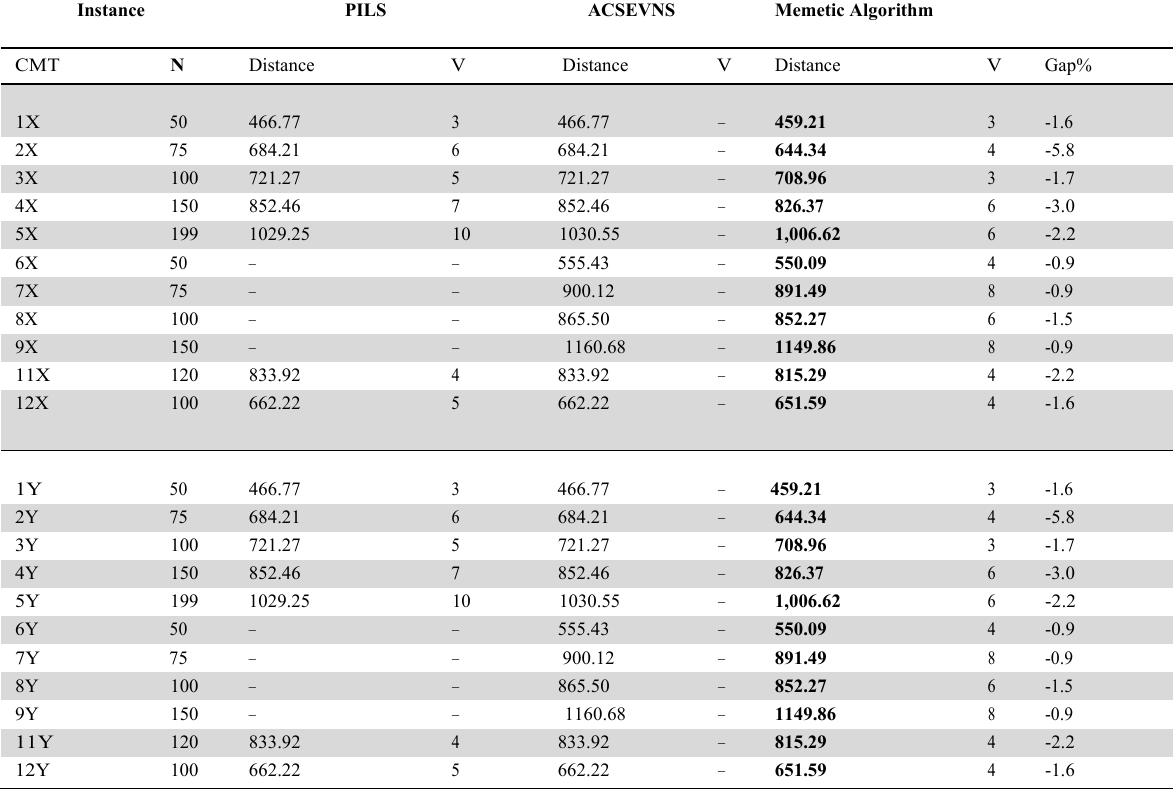
Comparison of MA with PILS and ACSEVNS for static